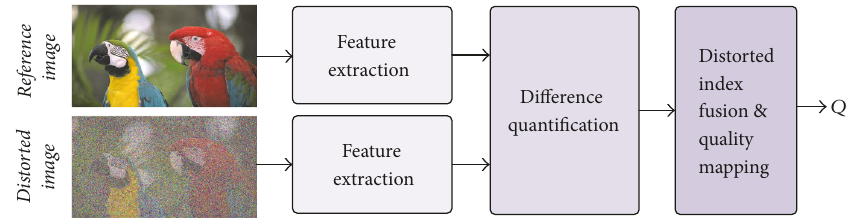
Figure 2: Scheme of an IQA